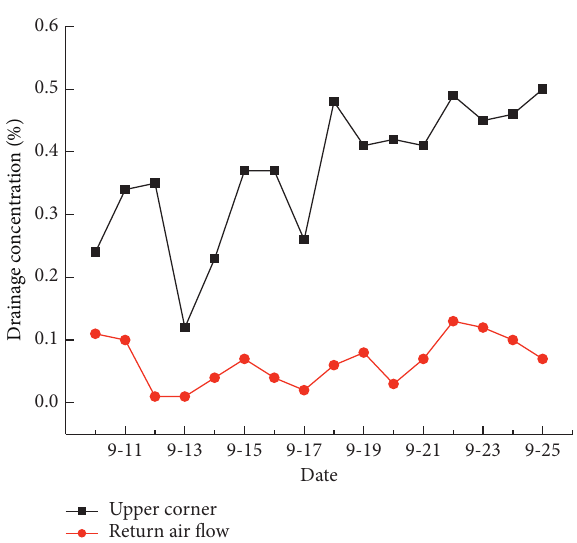
Figure 15: Gas concentration in upper corner and return air flow of working face during initial mining.